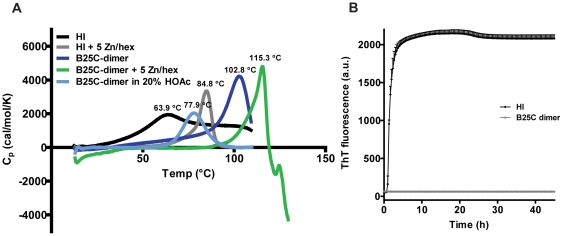
Assessing the stability of the B25C-dimer compared to HI.
A: DSC of HI and the B25C-dimer. B: ThT fibrillation assay of 0.3 mM B25C-dimer (grey diamonds) and 0.6 mM HI (black diamonds) with incubation at 37°C and vigorous shaking as described in “Methods”. Both samples contained 7 mM phosphate adjusted to pH 7.4.